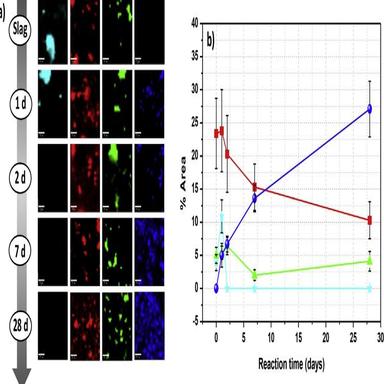
a) Raman images by CRM (35 × 35 μm2 , integration time of 1.0 s and 35 × 35 pixels) of the evolution of the main phases present in the alkali-activated slag at different ages (1, 2, 7 and 28 days): akermanite (in cyan), calcite (CaCO3, in red), the symmetric stretching bonds of SiO4 from slag (in green), and the presence of C-A-S-H gel (in blue); b) semi-quantitative determination of the presence of the main phases present during the alkali-activation of blast furnace slag: akermanite (in cyan), calcite (in